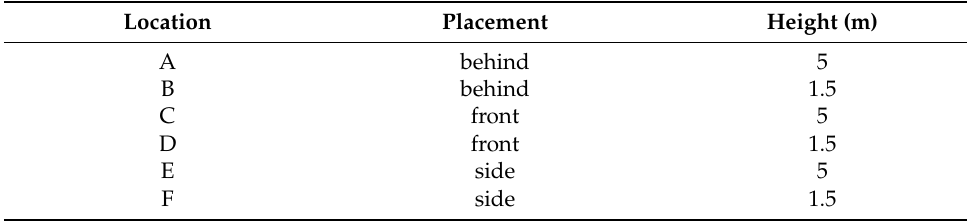
Table 1. Locations with different placements and